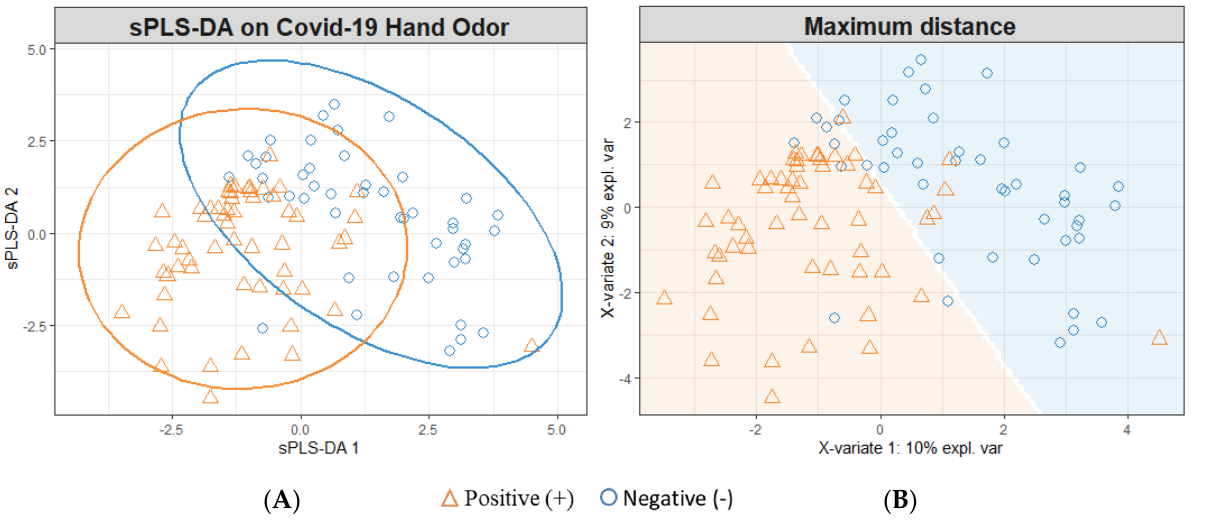
Figure 1. All-Timeframes SARS-CoV-2 sPLS-DA Model; (+) SARS-CoV-2 Samples vs. ( − ) SARS-CoV- 2 Samples. ( A ) Individual sample plot; ellipses = 95% CI. ( B ) Individual sample plot; background delineates class assignment.